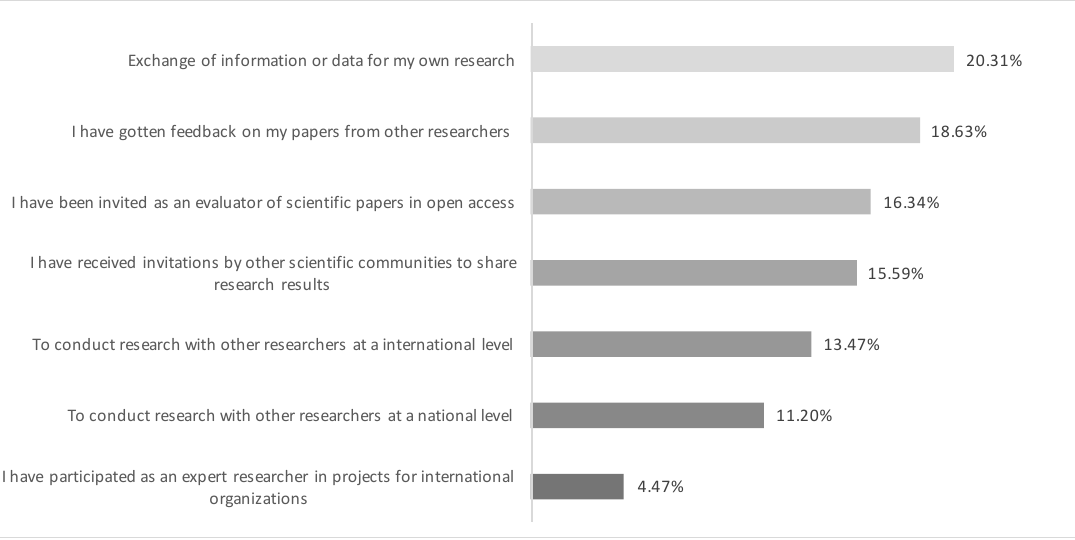
Figure 6. The main opportunities provided by open science for Colombian researchers.